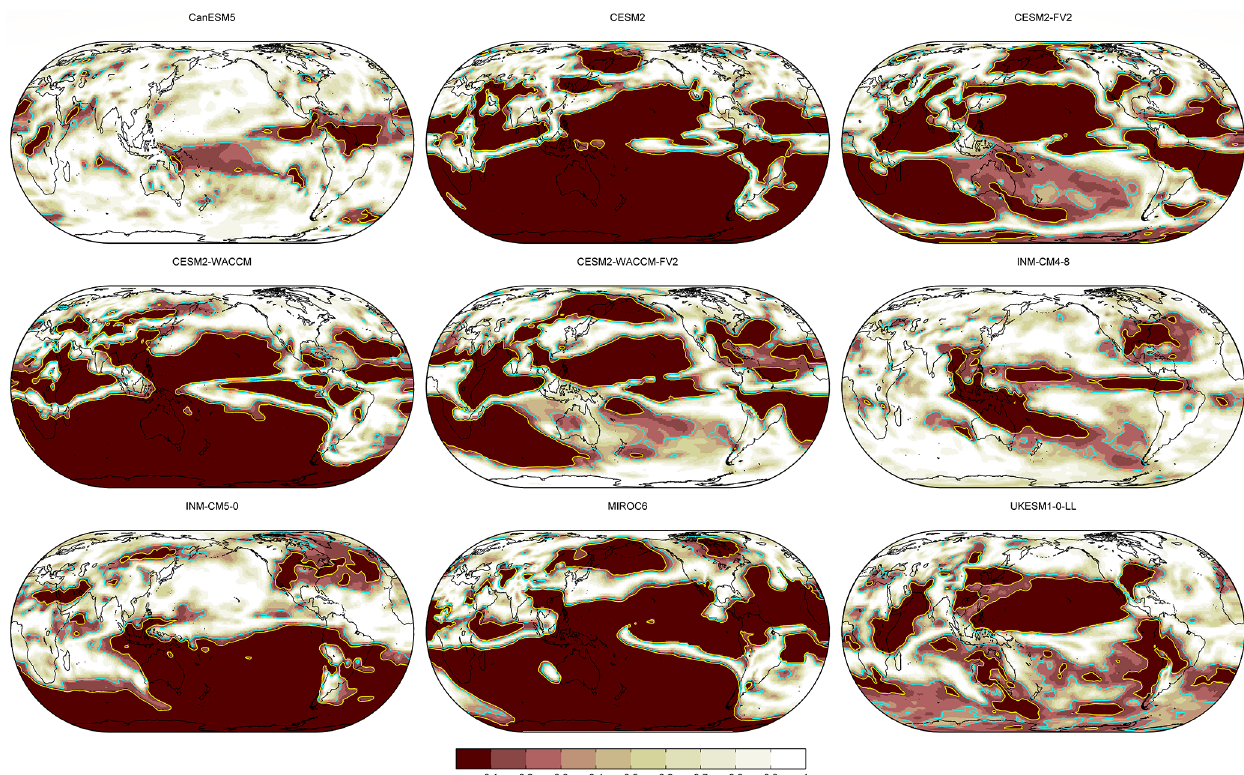
Figure 5. As in Fig. 1, except for the probability for the absence of Granger causality from ENSO to annual mean dust aerosol optical depth over the period 1850–2014 for the historical simulation of nine different models (see Table S2). ENSO: El Niño–Southern